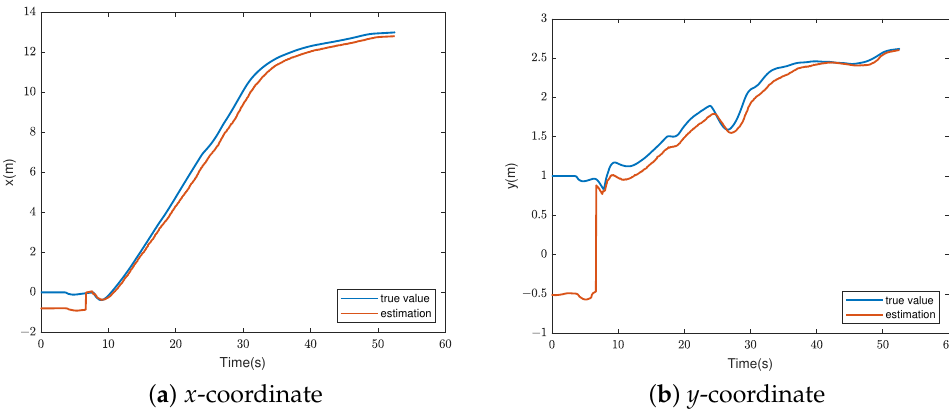
Figure 12. Comparison of true and estimated coordinates. ( a ) True and estimated x -coordinate and ( b ) y -coordinate of quadrotor 2.